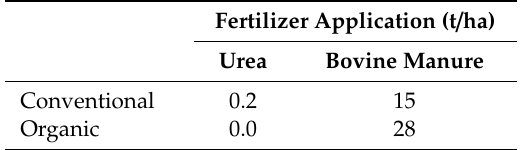
Table 1. Fertilizer application on conventional and organic